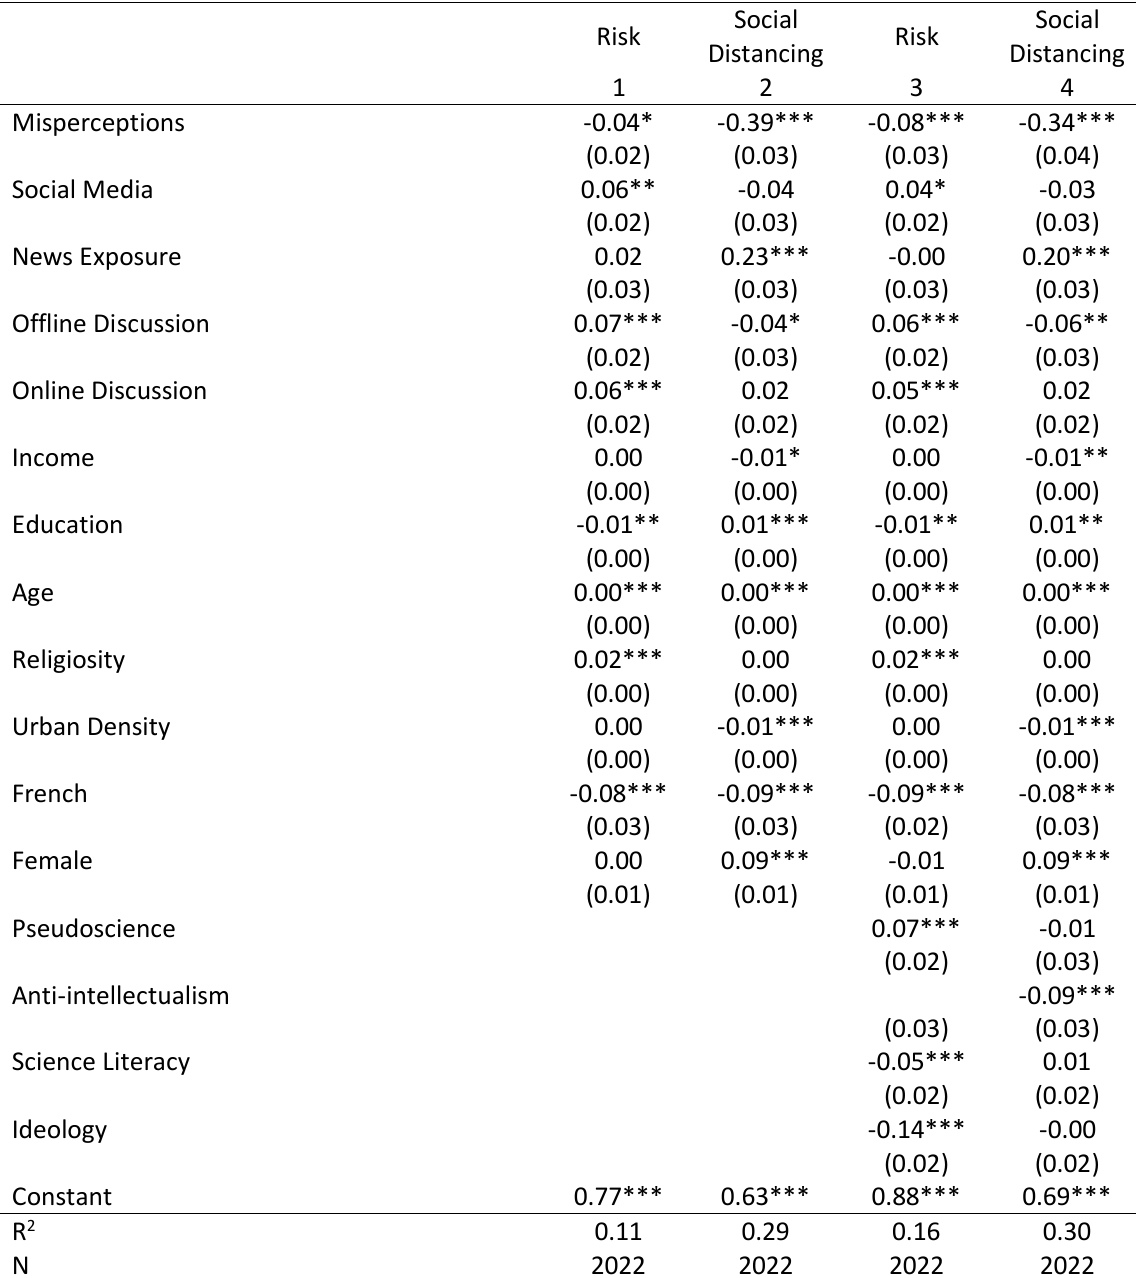
Table A4. OLS Estimates for Figure